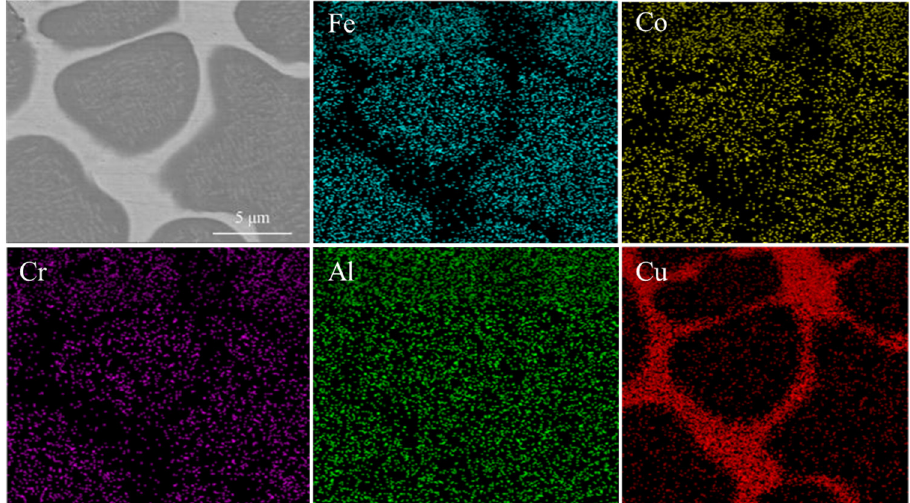
Figure 5. EDS of the FeCoCrAlCu HEA coating . Table 3. Chemical composition of the FeCoCrAlCu HEA coating.